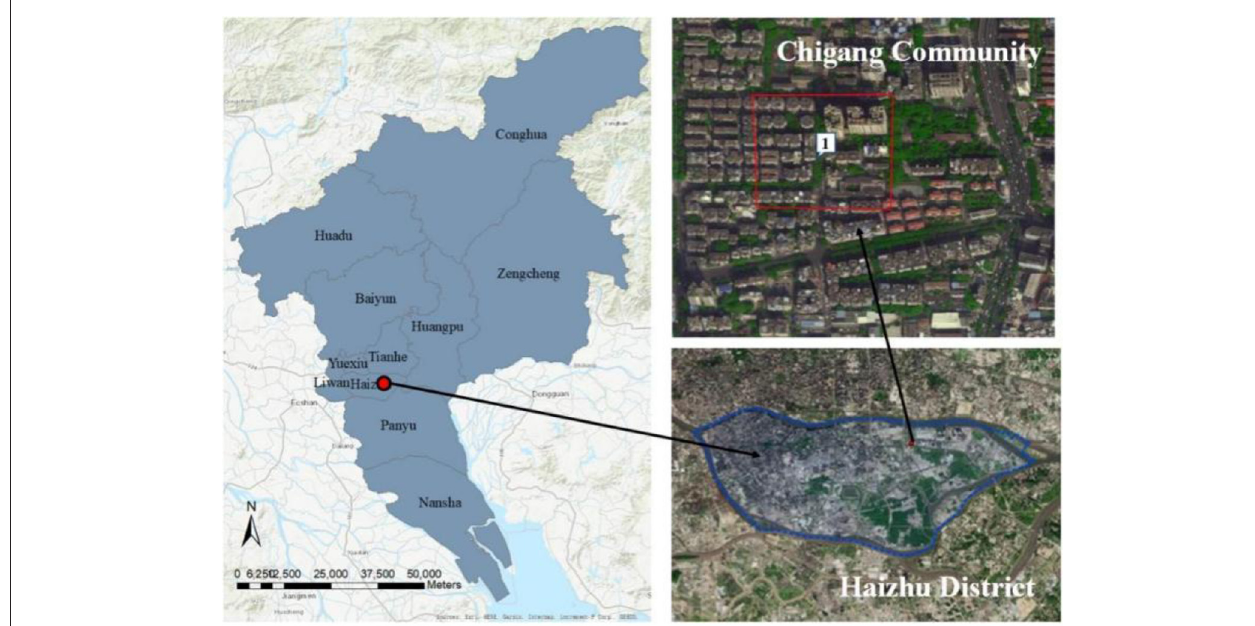
FIGURE 1 | Bitmap of the study area (from Baidu Satellite Map).